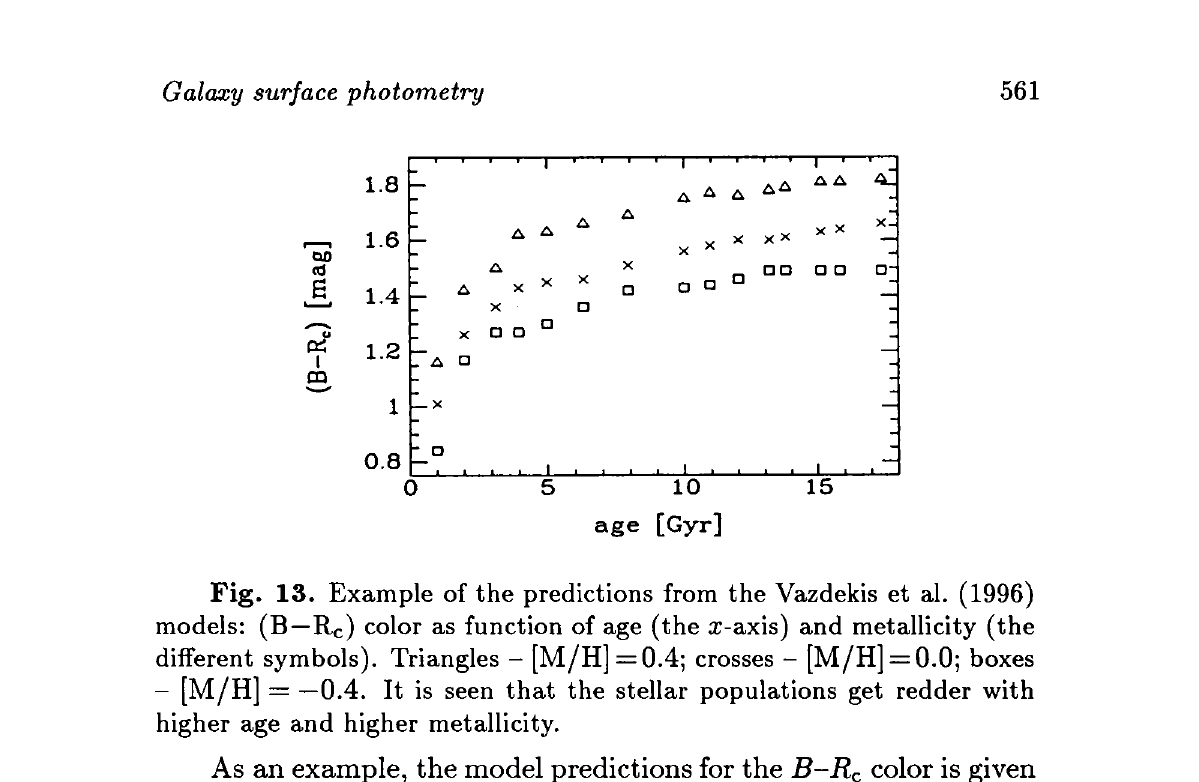
Fig. 13. Example of the predictions from the Vazdekis et al. (1996) models: (B—R c ) color as function of age (the x-axis) and metallicity (the different symbols). Triangles - [M/H] = 0.4; crosses - [M/H] = 0.0; boxes - [M/H] = —0.4. It is seen that the stellar populations get redder with higher age and higher